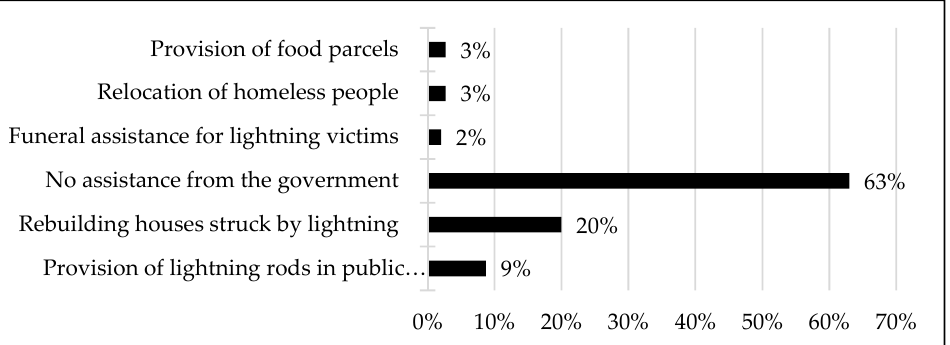
Figure 6. Interaction of the community with the local government.